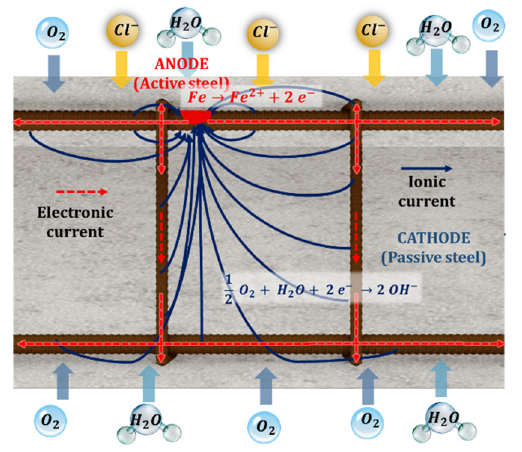
Figure 1. Localized corrosion due to chlorides.